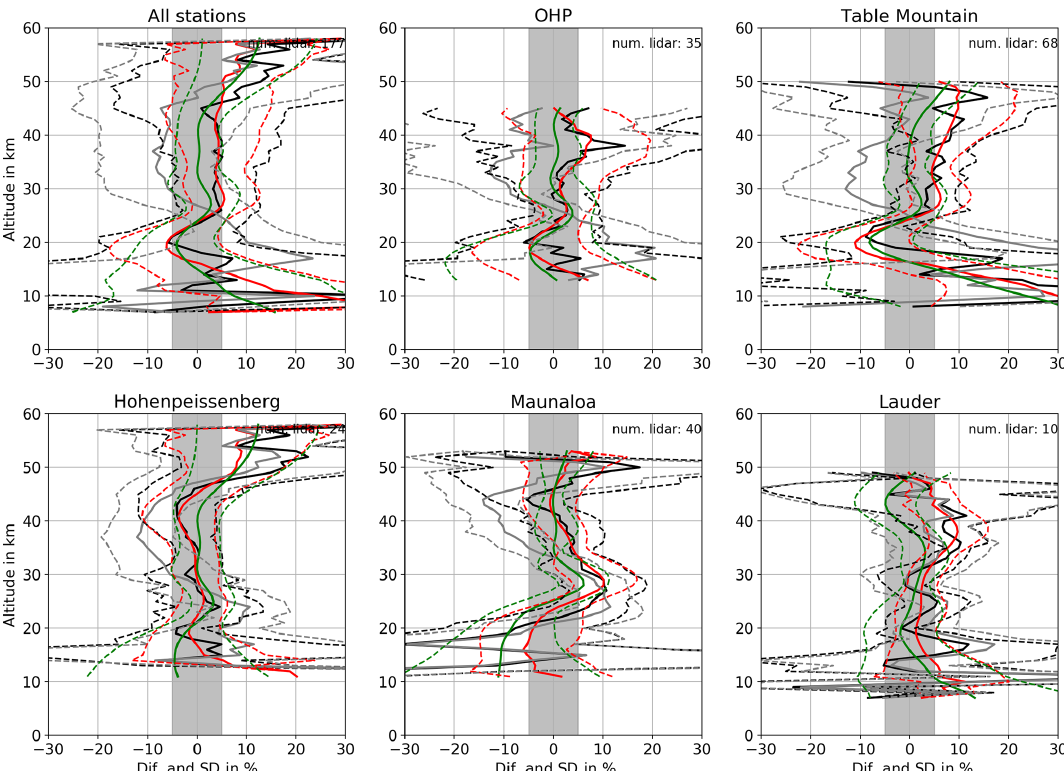
Figure 9. Comparison between TROPOMI ozone profile retrieval and the results from five different lidar stations and all-station average. The colours are the same as in Fig. 7 but for lidar instead of ozonesonde data. In addition, the difference between the TROPOMI ozone profile retrieval and MLS results convolved with the TOPAS averaging kernels is shown in green. Only collocated MLS profiles are used (distance < 1000km and time <